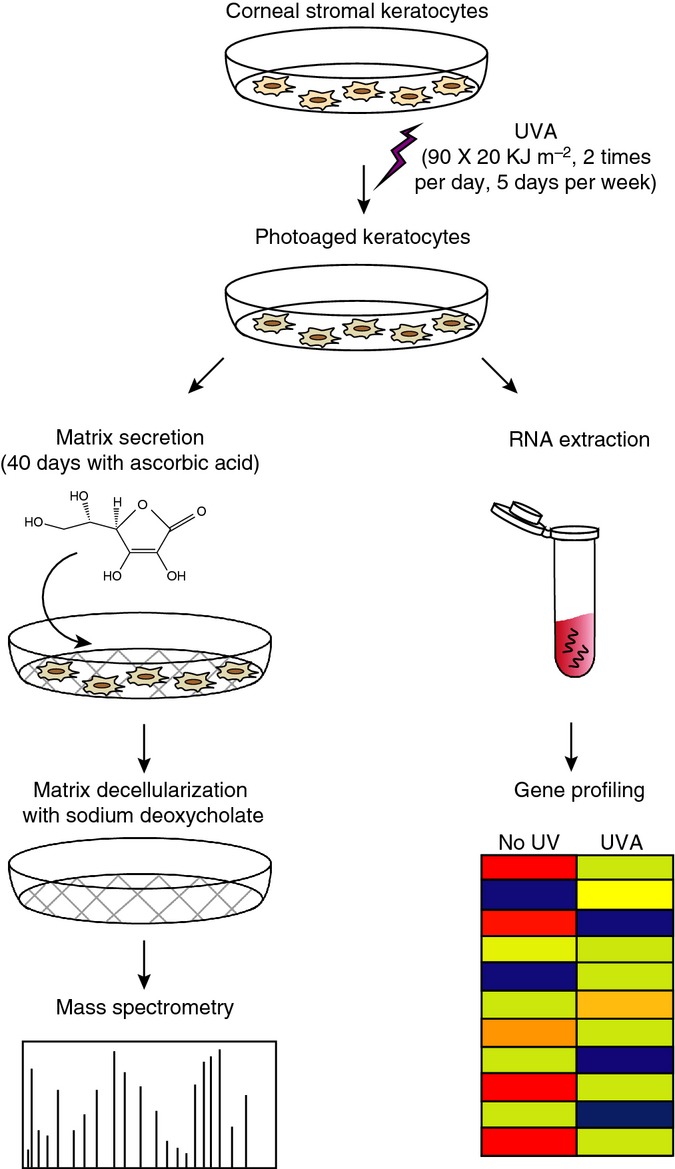
Schematic representation of the UVA irradiation protocol and further analysis of transcriptomic and proteomic changes induced by irradiation. Corneal stroma keratocytes were isolated from human corneas, cultured, and irradiated in cellulo using 20 kJ m−2 UVA, two times per day, 5 days per weeks for a total of 90 irradiations or 1800 kJ m−2. (1) RNA was isolated from irradiated or unirradiated control keratocytes, and the transcriptome was analyzed using microarray technology. (2) Irradiated corneal keratocytes and unirradiated controls were exposed to ascorbic acid in order to induce secretion and arrangement of extracellular matrix. This tissue engineering technique was used to reproduce corneal stroma in vitro. The tissue-engineered corneal stroma was decellularized using sodium deoxycholate, and the extracellular matrix (ECM) was then analyzed by mass spectrometry.